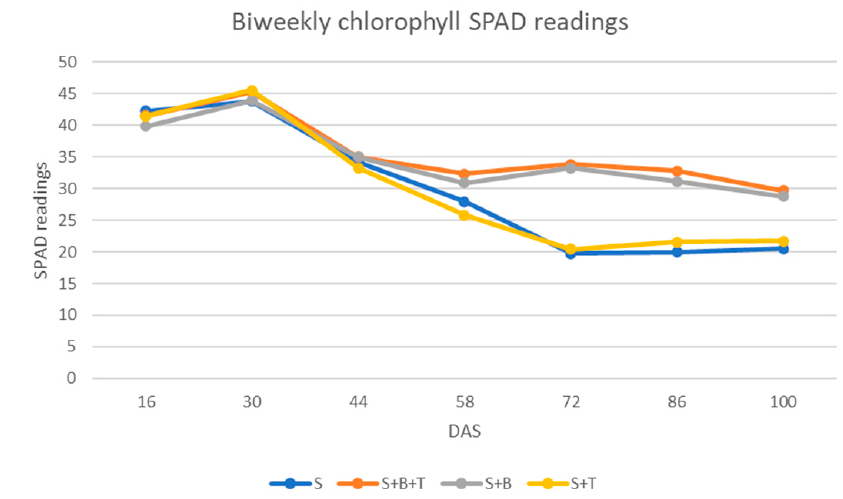
inoculated with Bradyrhizobium and treatment co-inoculated with Bradyrhizobium and Trichoderma (Table 4). Crops co-inoculated with Bradyrhizobium and Trichoderma , and those inoculated with Bradyrhizobium alone significantly increased biomass and yield of the species. Tables 5 and 6 show the Agronomy 2020 , 10 , x FOR PEER REVIEW interactive e ff ects of these microbes on peanut growth, development, and yield.